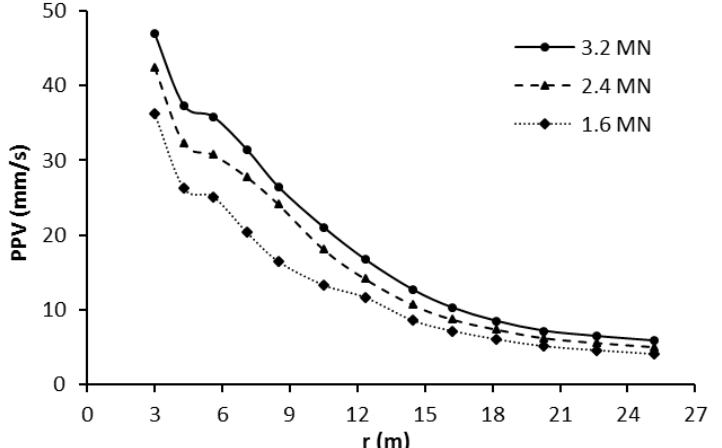
Fig. 9. Variation of PPV values on the ground surface with radial distance from pile axis for different hammer impact